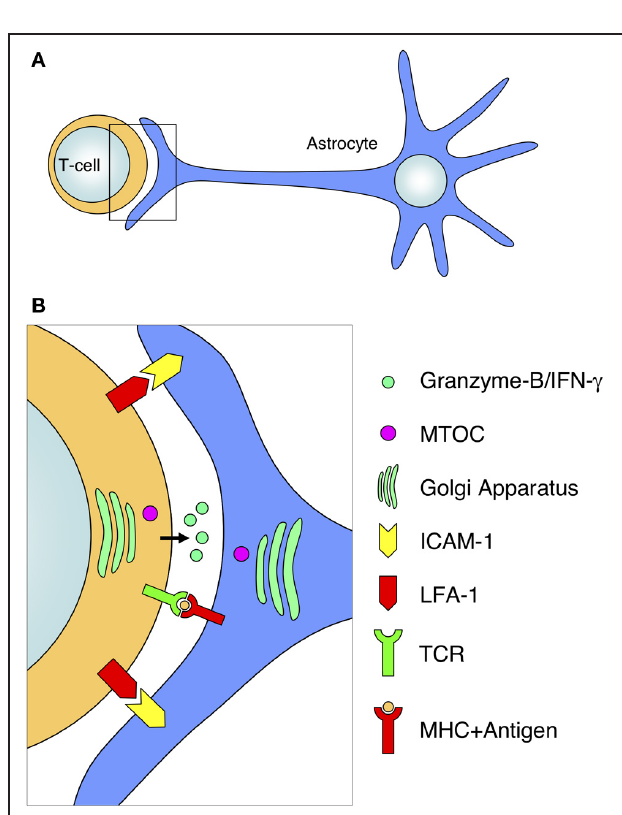
FIGURE 7 | Diagram of antigen-dependent T-cell–astrocyte interactions. The interaction of activated T-cells with MHC-expressing astrocytes involves a defined arrangement of various molecules and organelles. (A) Schematic representation of the interaction of a T-cell with an astrocyte at the level of the astrocytic protrusion. (B) Magnification of the T-cell–astrocyte interface from the frame depicted in (A) . The T-cell–astrocyte interface is characterized by the segregation of adhesion molecules (such as LFA-1 and ICAM-1), the interaction of the TCR with MHC molecules, the release of cytotoxic compounds (such as Granzyme-B or IFN-gamma) into the intercellular space; and the rearrangement and polarization of organelles toward the interface (for example, the relocation of the MTOC and Golgi apparatus in both cell